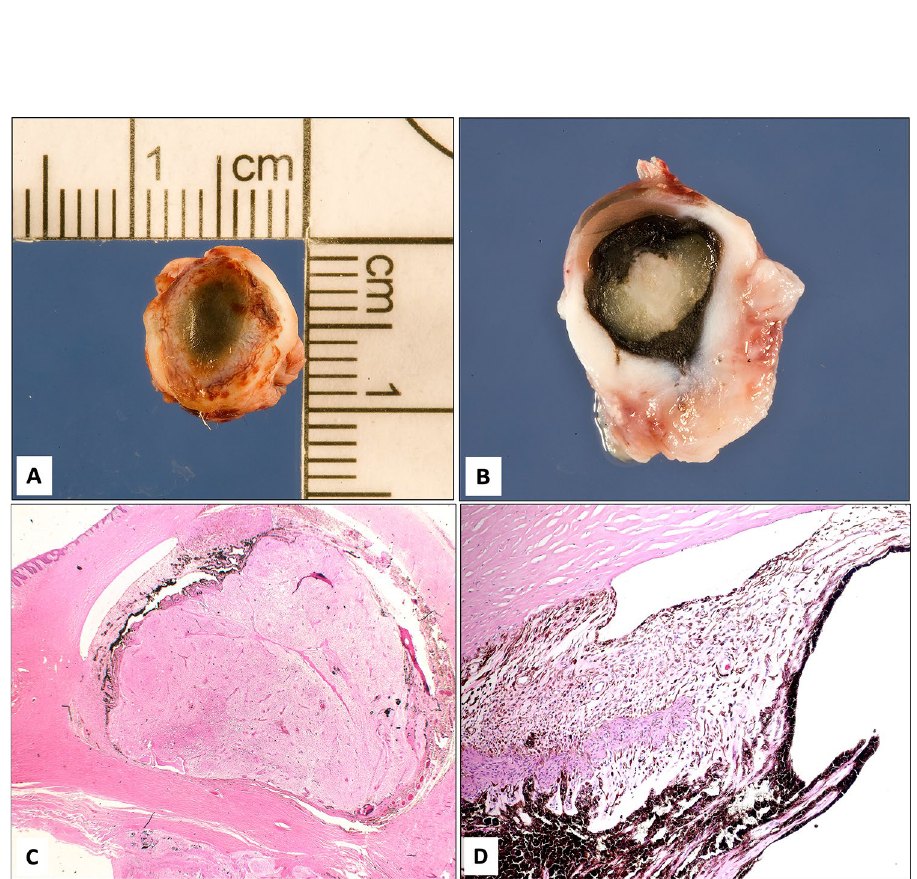
Figure 2. ( A,B ) The gross appearance of a globe with severe microphthalmos. ( C ) Histopathological appearance of the globe with absent lens and dysgenesis of the anterior chamber angle structures and gliosis of the retina (original magnification × 12.5, hematoxylin and eosin). ( D ) Higher power of the anterior segment showing absent angle structures with uveal tissue adherent to the back of the cornea and obliterated narrow anterior chamber (original magnification × 100, hematoxylin and